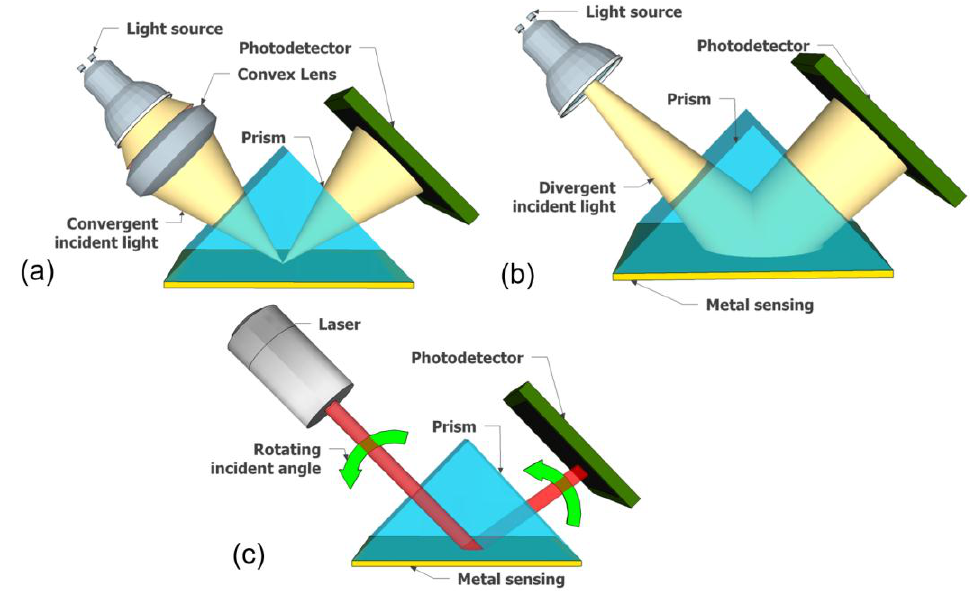
Figure 10. Optical configuration of incident light in SPR sensor apparatus in Kretschmann configuration. ( a ) Convergent, ( b ) divergent, ( c ) rotating for incident angle scanning.